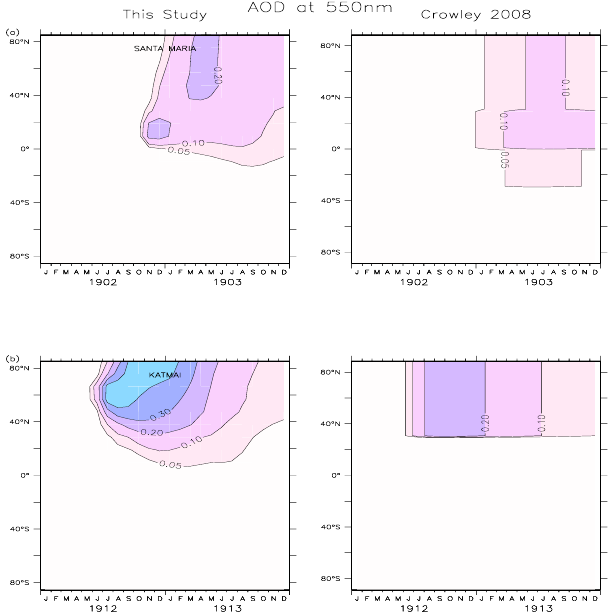
Fig. 8. Latitudinal distribution of the optical depth in VIS (550nm) for the Santa Maria (1902) and Katmai (1912) eruptions for this study (left column) and Crowley et al. (2008) (right